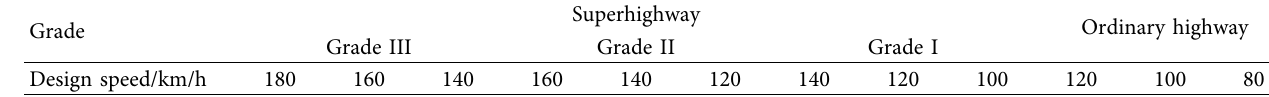
Table 2: Adjusted classification of highways after peer review.